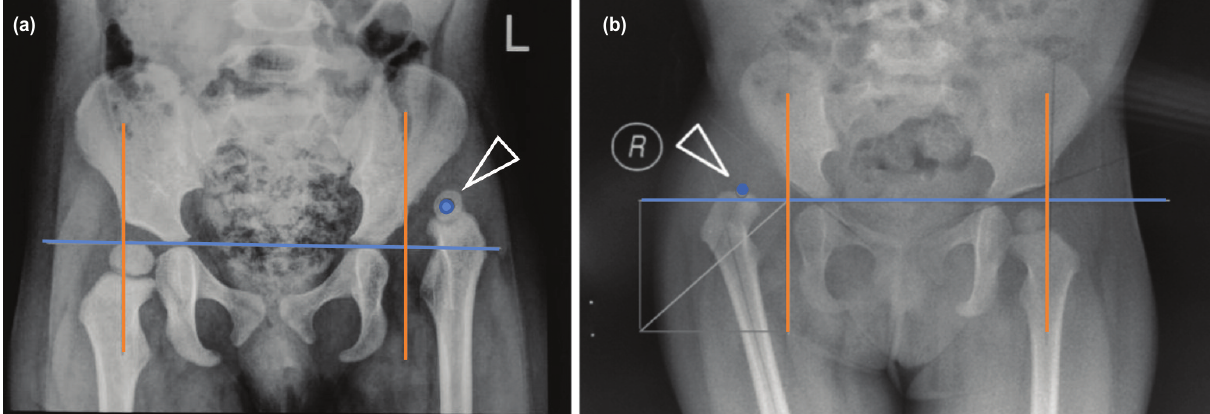
(a) One example of AP pelvic radiograph with grade 4 Tonnis classification and (b) grade 4 IHDI classification. From the Fig. 3: radiograph it can be seen that the ossific nucleus of the right femoral head is not visible on the radiograph.